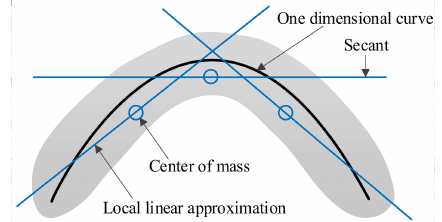
Figure 1. Schematic diagram of local linear approximations.